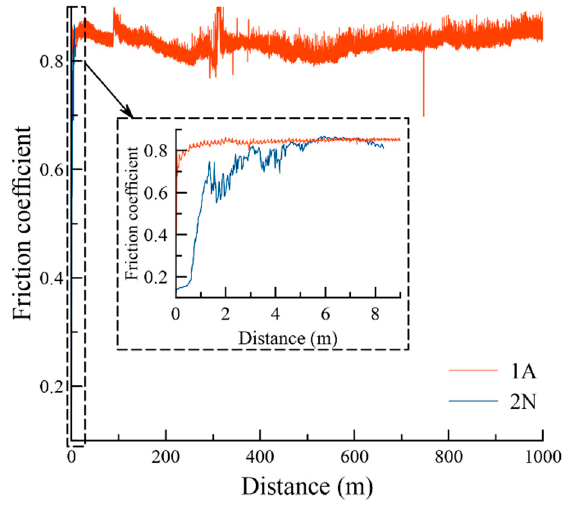
Figure 6. The friction coefficient for Coatings 1A and 2N.